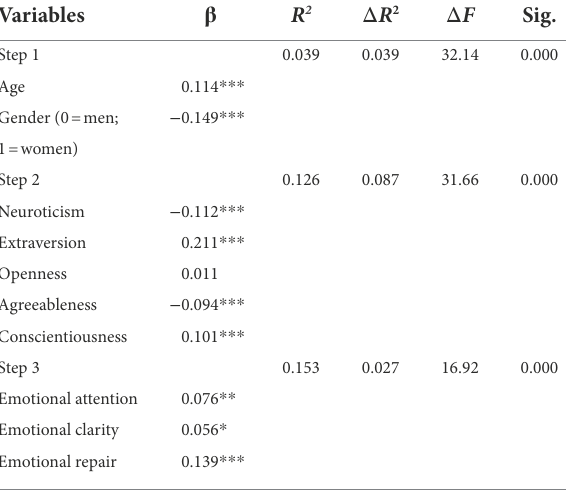
TABLE 2 Results of hierarchical regression analysis to predict entrepreneurial self-efficacy based on age, gender, personality, and emotional intelligence.